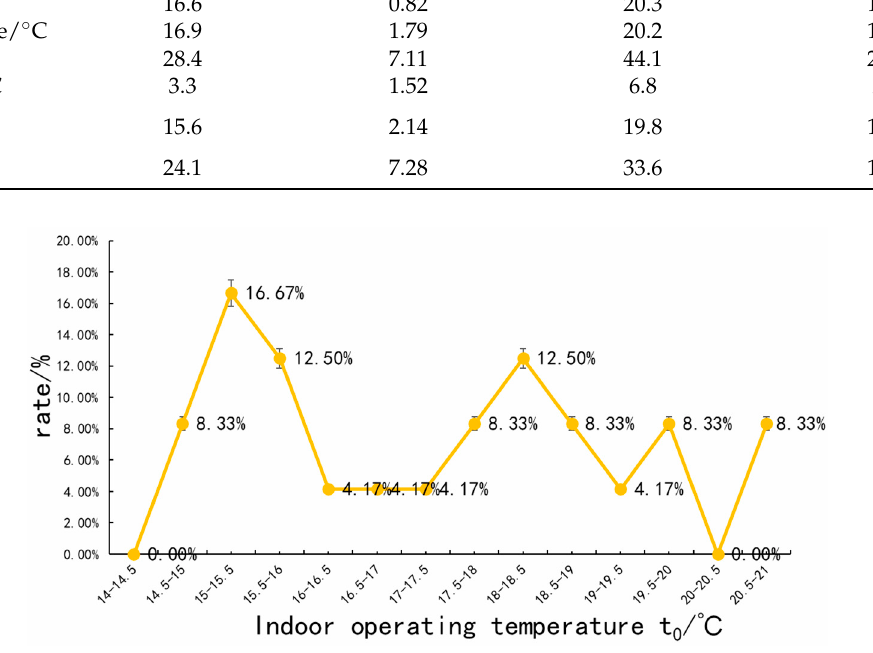
Figure 10. Frequency of the distribution of indoor operating temperature (source: